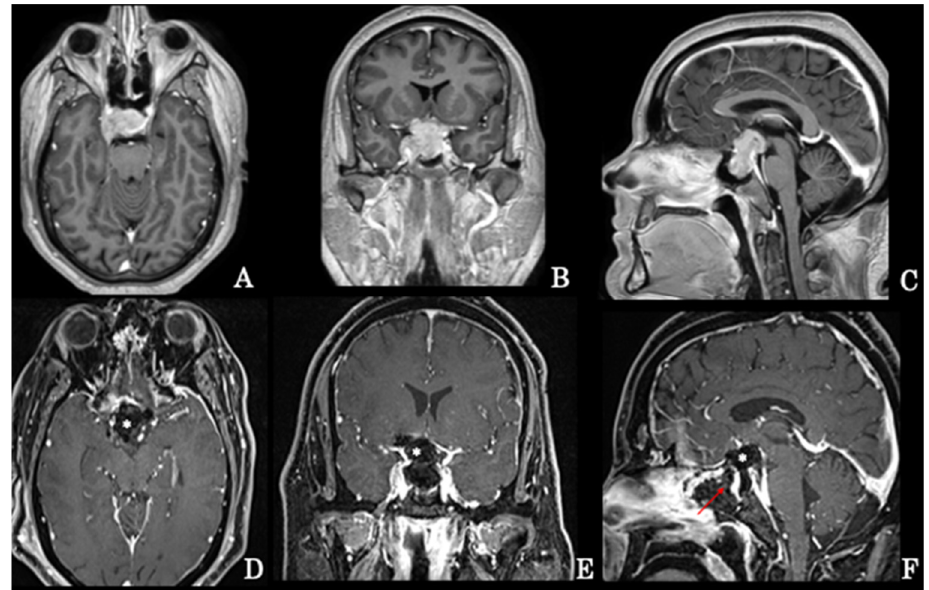
Figure 1. Preoperative axial ( A ), coronal ( B ), and sagittal ( C ) MRI scans of a giant intra-suprasellar pituitary adenoma also extending into the right cavernous sinus that has undergone extended endoscopic removal. Early postoperative axial ( D ), coronal ( E ), and sagittal ( F ) MRI scans revealing the gross total resection of the tumor; the surgical cavity has been filled with autologous fat (*) and the osteodural breach covered with a pedicled nasoseptal flap (arrow) according to the 3F